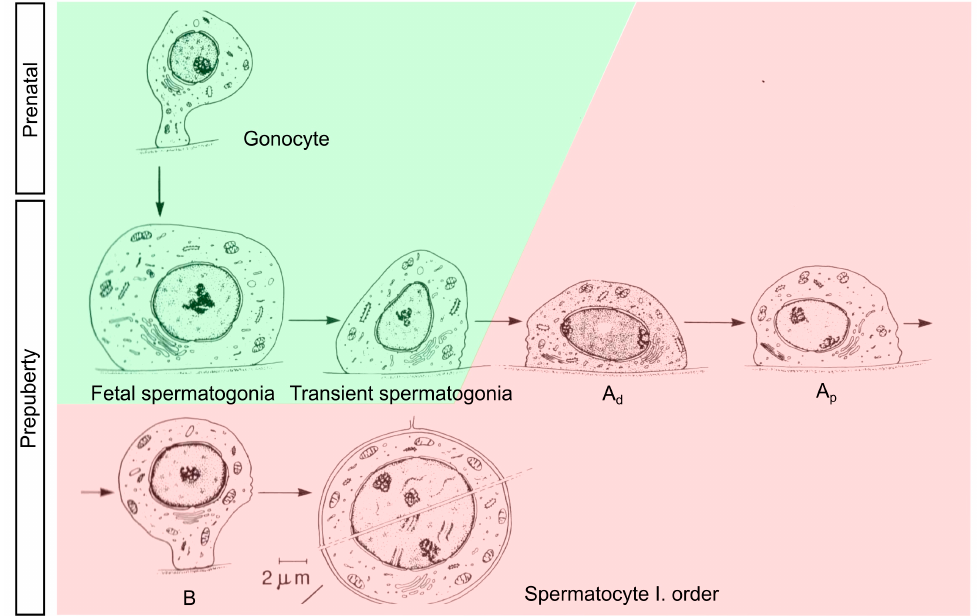
Figure 2. Male germ cell development. Differentiation of gonocytes into Ad spermatogonia is highlighted as color change from green to red (figure adapted from Hadziselimovic and Herzog [26]). 3.1. Decreased Expression of Gonocyte and Spermatogonial Marker Genes in Testes with Altered Mini ‐ Puberty Of the six gonocyte markers selected, POU5F1 and TFAP2C showed lower expression levels in